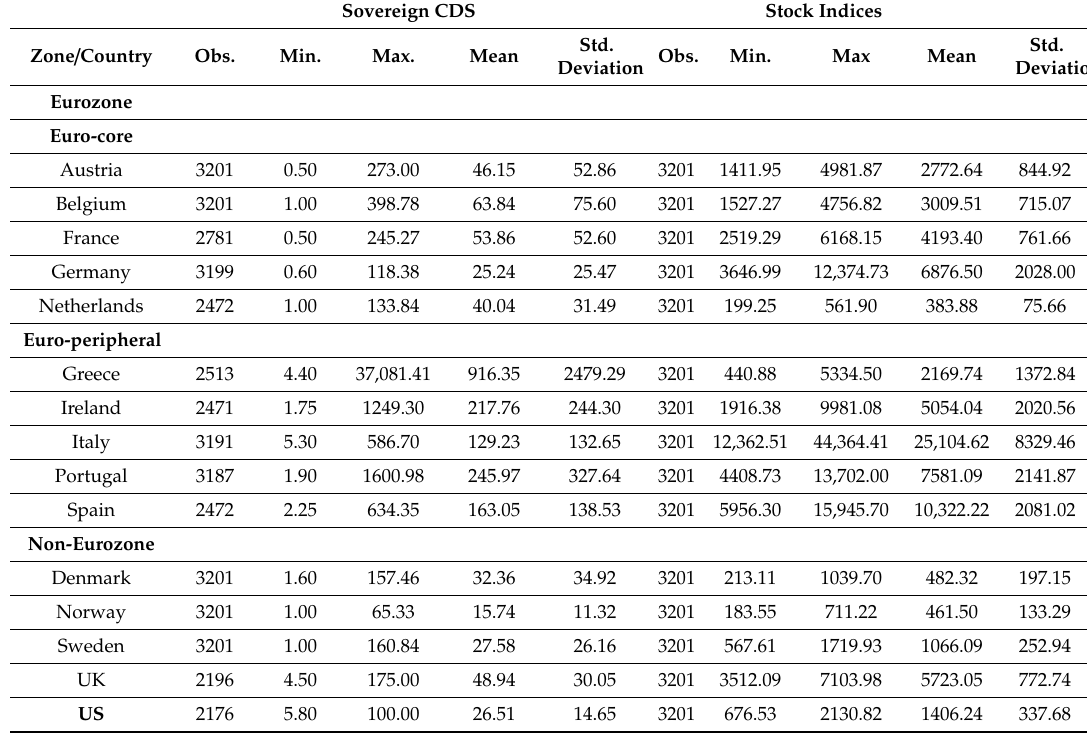
Table 1. Main descriptive statistics of daily stock indices and sovereign credit default swap (CDS) spreads. Sovereign CDS Stock Indices Std. Obs. Zone / Country Obs. Min. Max. Mean Deviation